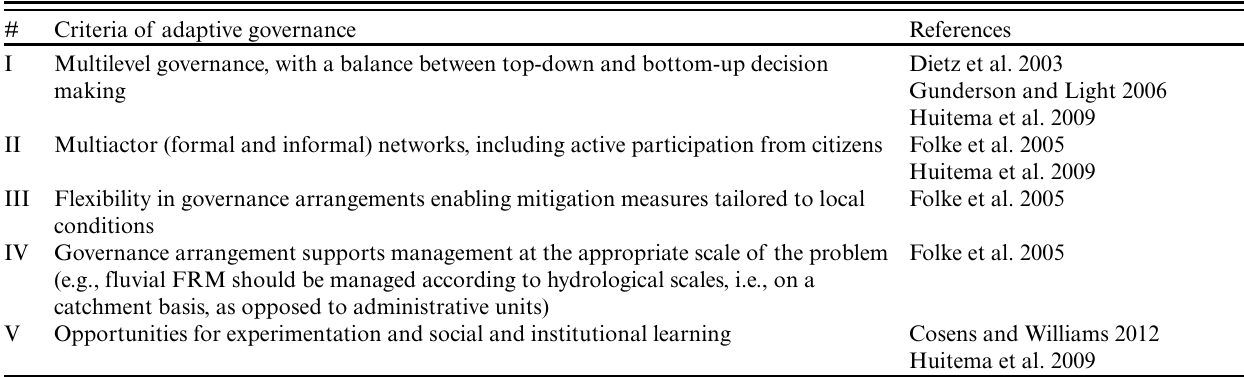
Table 1 . Conceptual framework for analyzing flood mitigation through the lens of adaptive